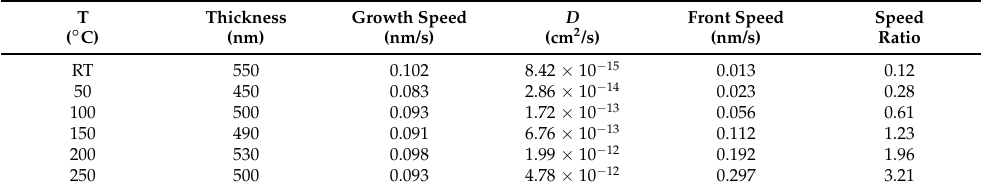
Table 4. Comparison of film growth and diffusion front